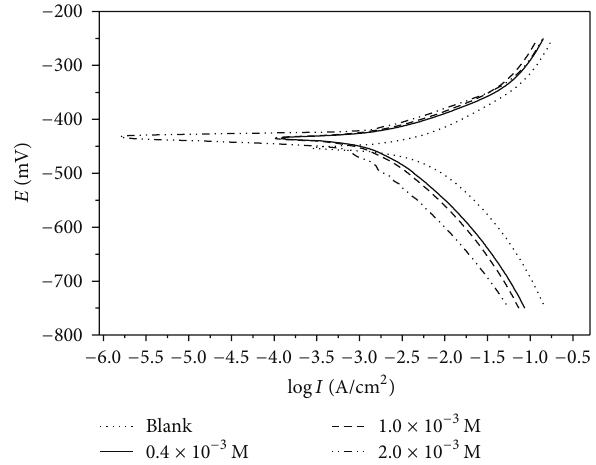
Figure 7: Polarization curves for mild steel in 1N H 2 SO 4 in absence and presence of different concentrations of inhibitor (03).